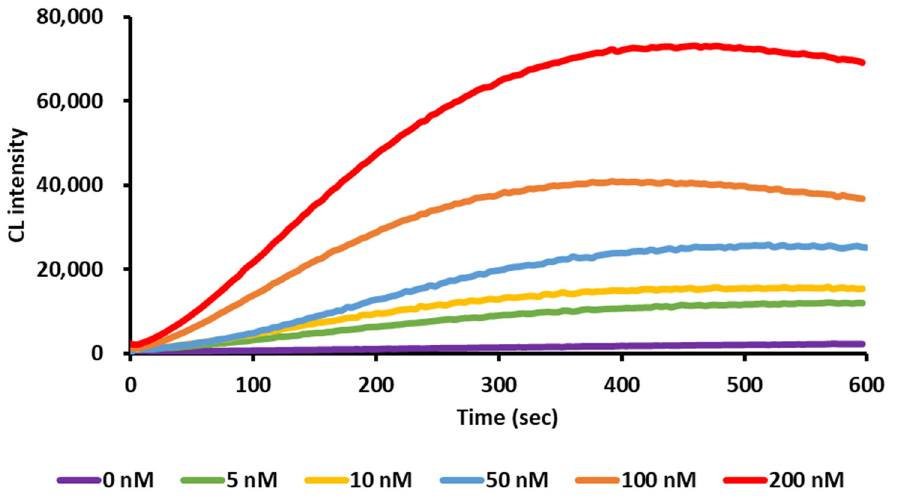
Figure 3. Time profile of the CL intensity of Biotin-DexDox.